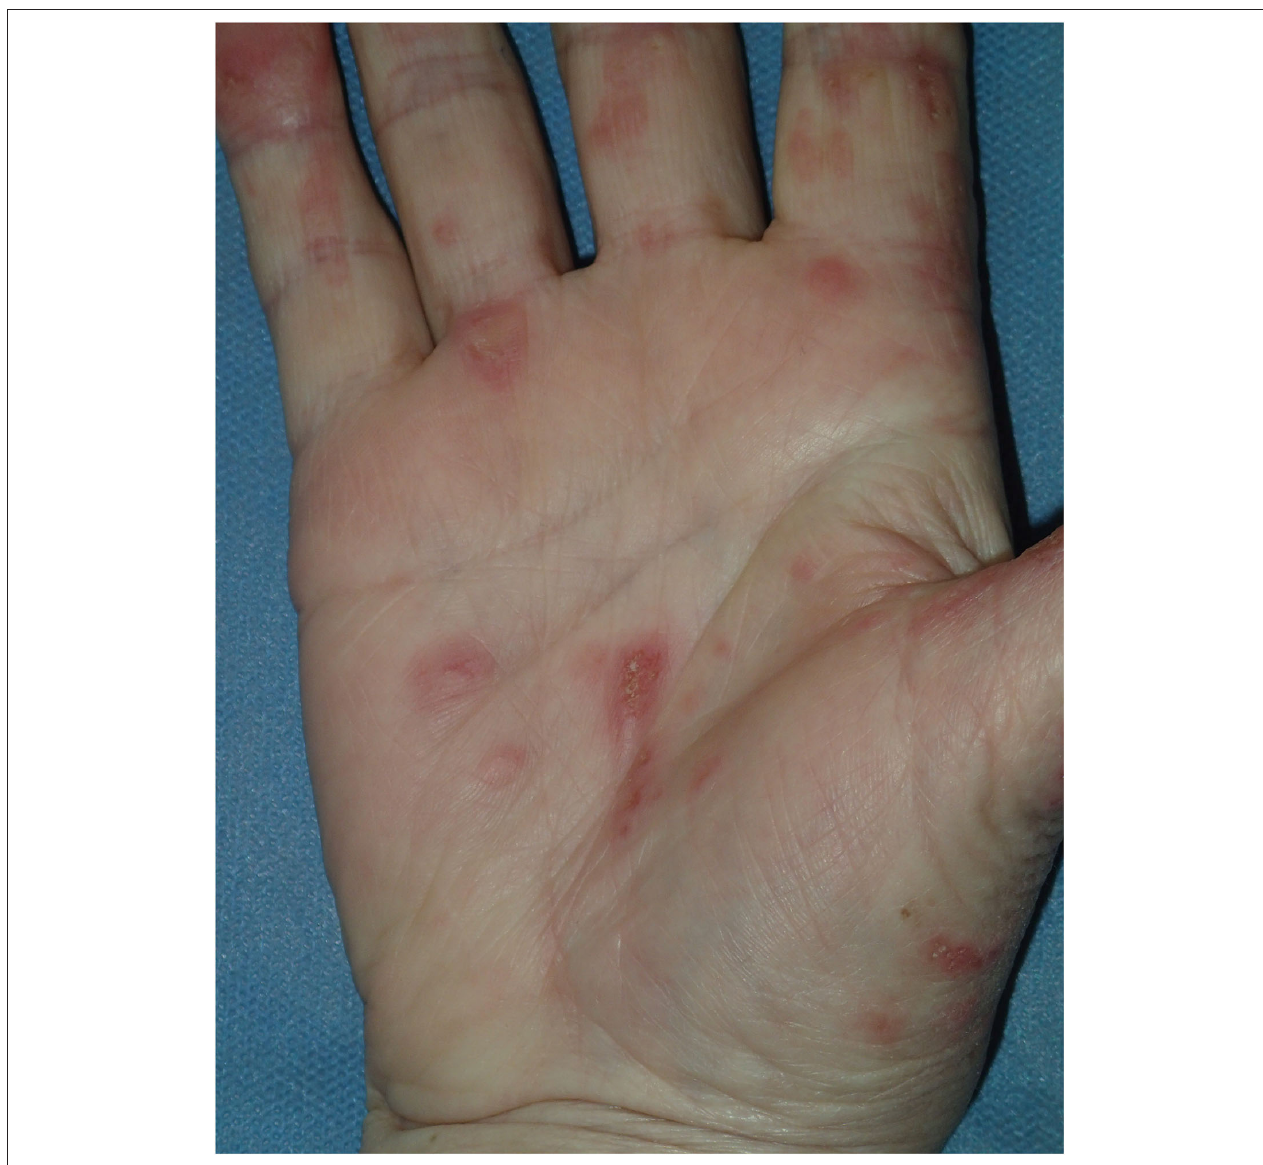
FIGURE 2 | Flat targetoid erythema multiforme (EM)-like lesions on the palmar skin, compatible with Rowell